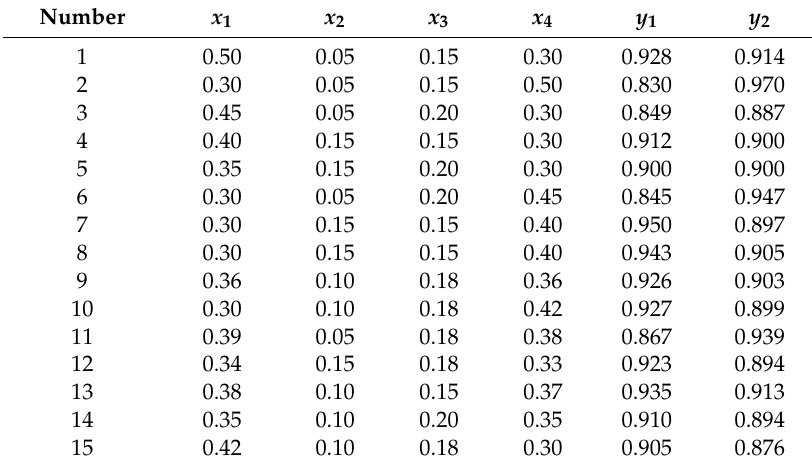
Table 7. Emissivity of each